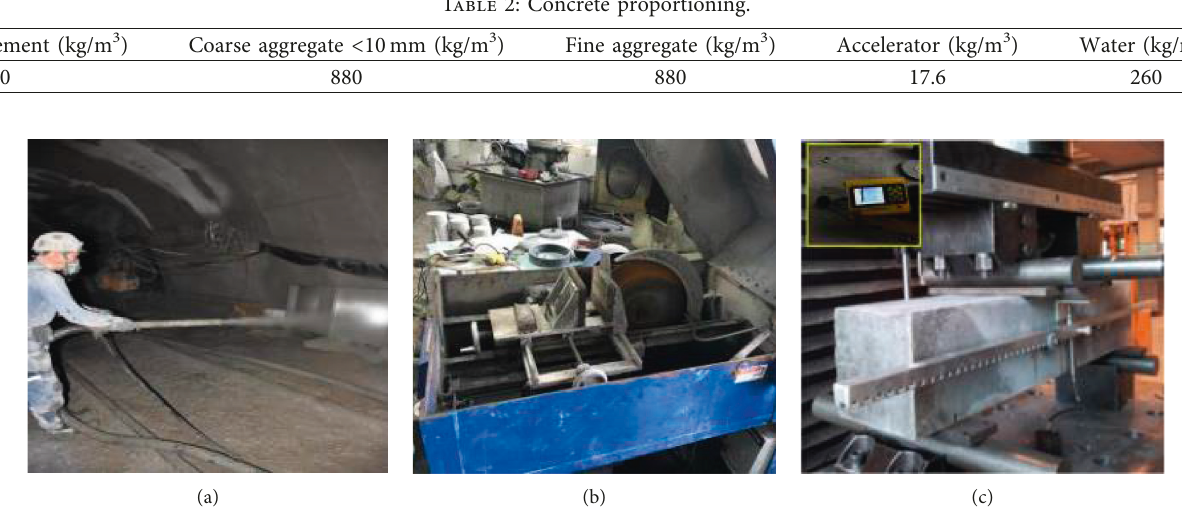
Table 2: Concrete proportioning.